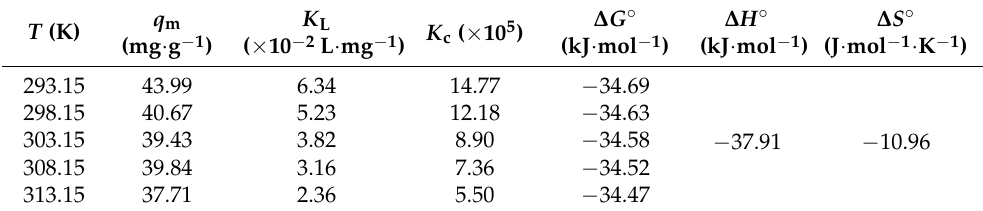
Table 3. Calculated results of thermodynamic parameters from Langmuir isotherm adsorption equation.